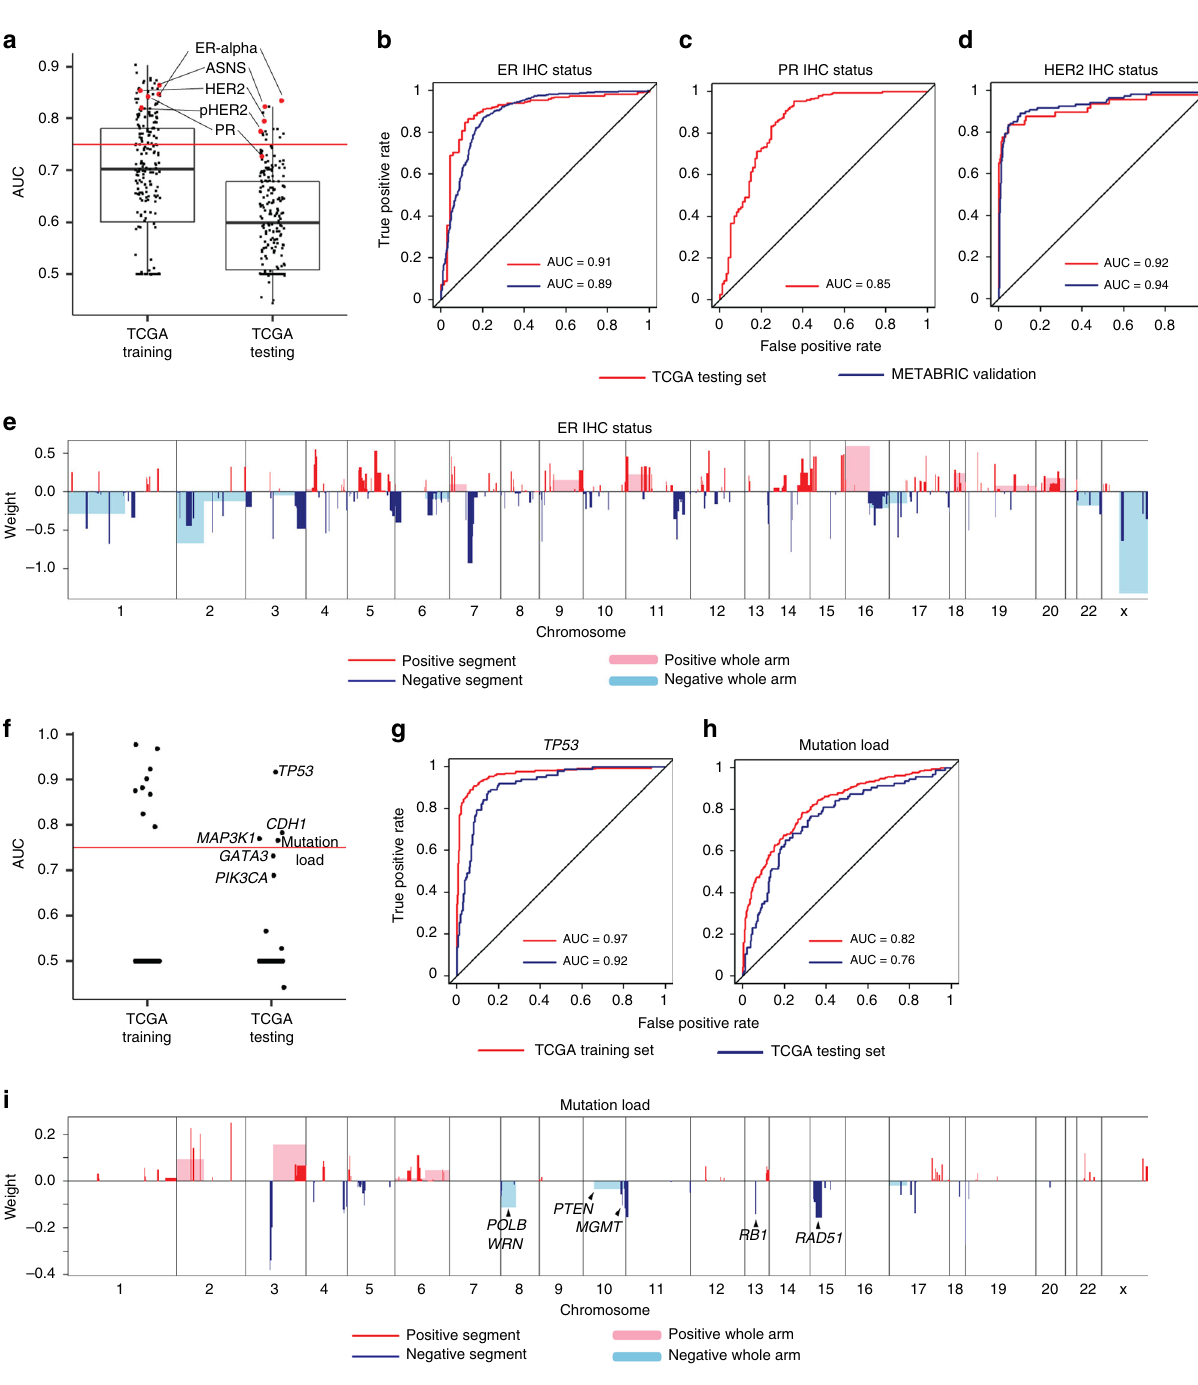
Fig. 4 Elastic Net models predicting individual protein expression and mutation status in breast cancer. a Box and whisker plots indicating the median score (horizontal line), the interquartile range (IQR, box boundaries) and 1.5 times the IQR (whiskers) of AUC values for predicting protein expression of 216 proteins and phosphoproteins from TCGA RPPA arrays. Five proteins of interest are highlighted with red dots. Red horizontal line indicates AUC = 0.75. b – d ROC curves and corresponding AUC values of TCGA test set and METABRIC validation set for predicting clinical ER status ( b ), clinical PR status ( c ), and clinical HER2 status ( d ). e Selected CNA segments and/or whole chromosomal arms and their coef fi cients of prediction model for clinical ER status. f Dot plots indicate AUC values for predicting individual somatic mutations. Red horizontal line indicates AUC = 0.75. g , h ROC curves and corresponding AUC values of TCGA training set and TCGA test set for predicting mutations of TP53 ( g ) and mutation load ( h ). i Selected CNA segments and/or whole chromosomal arms and their coef fi cients of prediction model for mutation load. (AUC 0.82) and ER clinical IHC status (AUC 0.89 on status (Supplementary Fig. 7e, f). In contrast, protein expression METABRIC validation set) when making use of DNA copy of ER cannot be explained by ESR1 copy number changes since number information only. The feature landscapes of these two ESR1 copy number gain/loss is rare 34 . Yet our Elastic Net models were able to accurately predict ER RPPA protein expression models were complex with many positive and negative predictors.